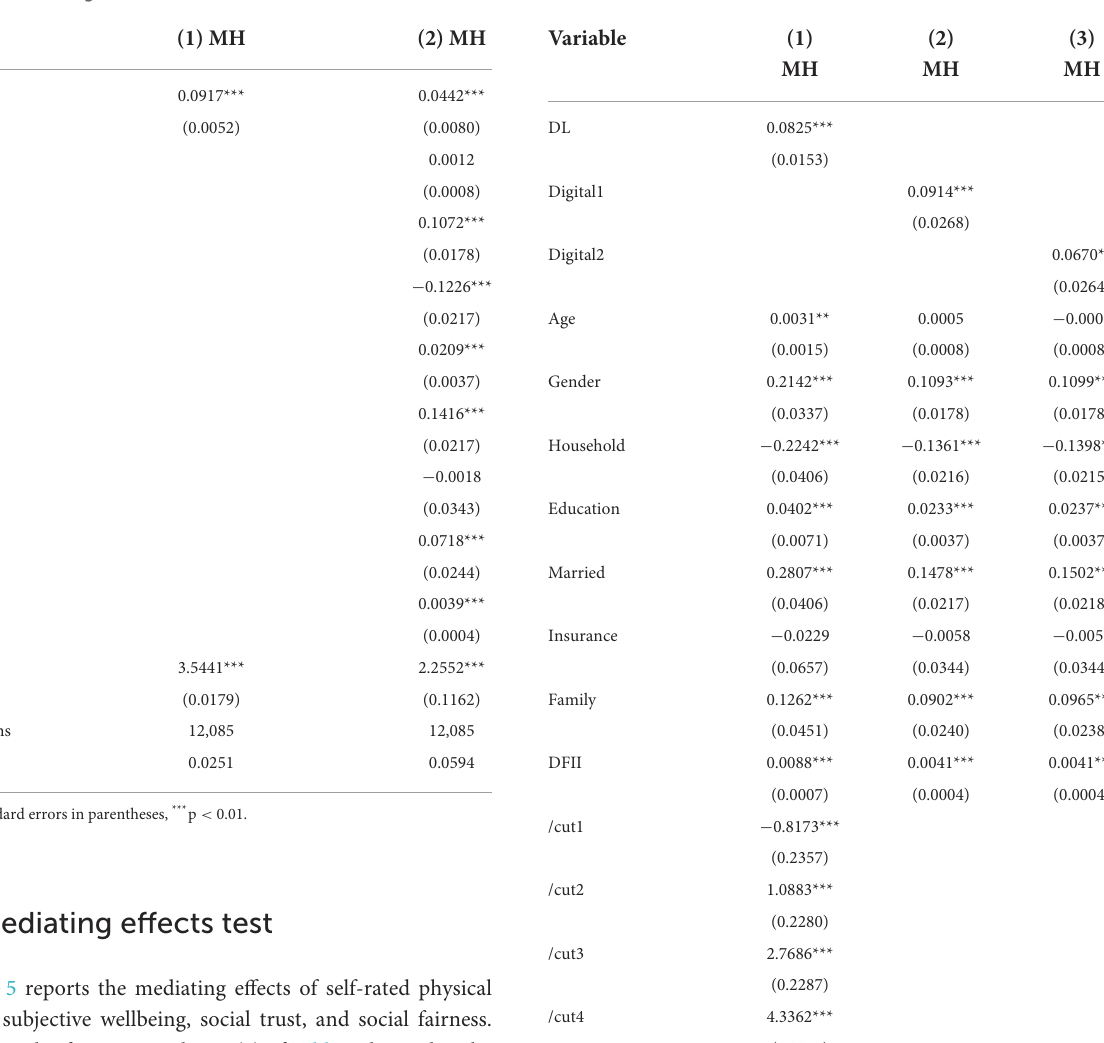
TABLE 3 Baseline regression results. TABLE 4 Robustness